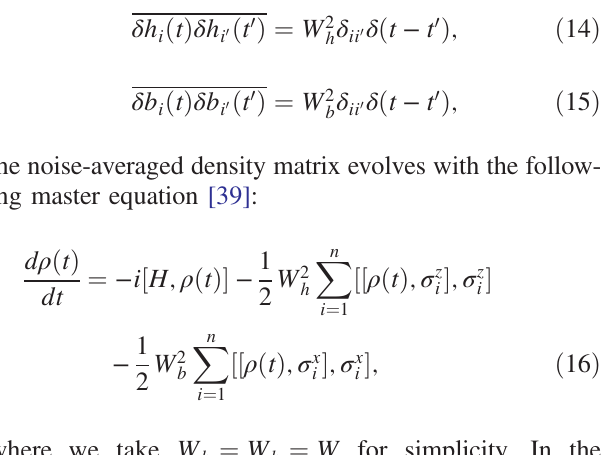
FIG. 4. Errors in the fidelity (upper panel) and final energies (lower panel) evolved with the bang-bang and QAA protocols in the presence of noise with different strengths for n ¼ 5